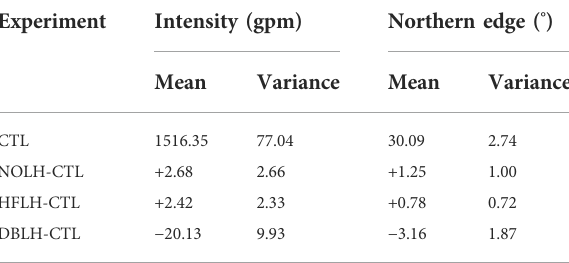
TABLE 3 Indices of the intensity and the northern edge of the WPSH and their anomalies in the sensitivity